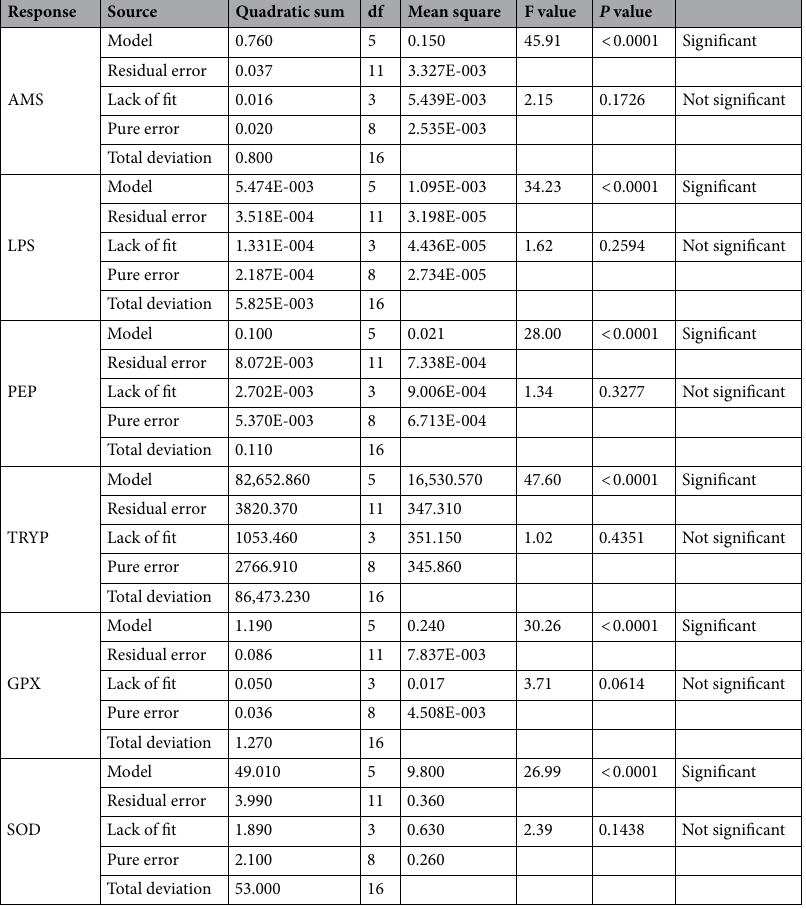
Table 1. Model variance analysis of digestive indexes. AMS Amylase activity in hepatopancreas, LPS Lipase activity in hepatopancreas, PEP Pepsin activity in hepatopancreas, TRYP Trypsin activity in